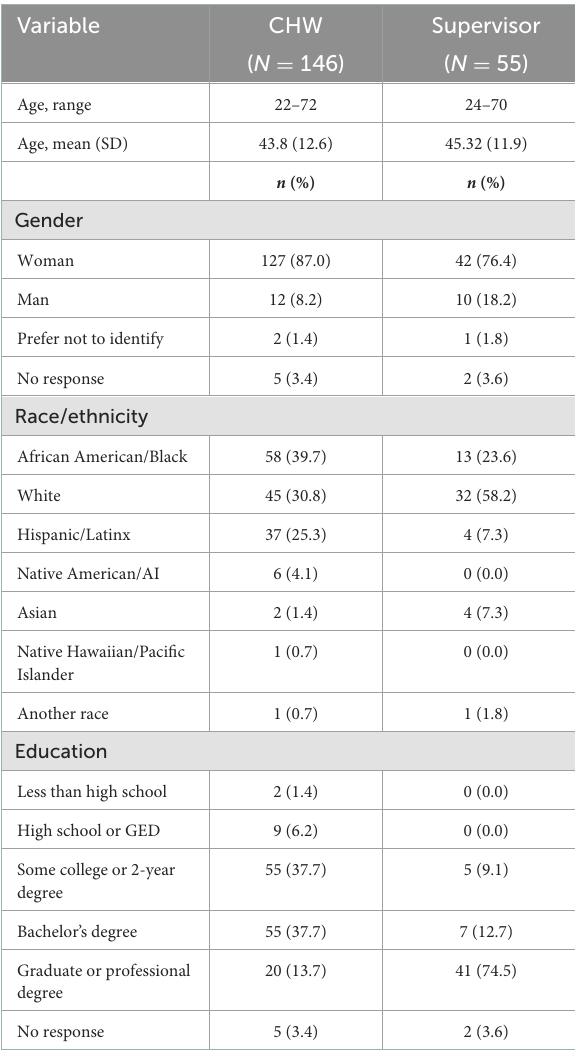
TABLE 2 Minimum CHW education required for hiring as reported by supervisors working with Medicaid managed care organizations.